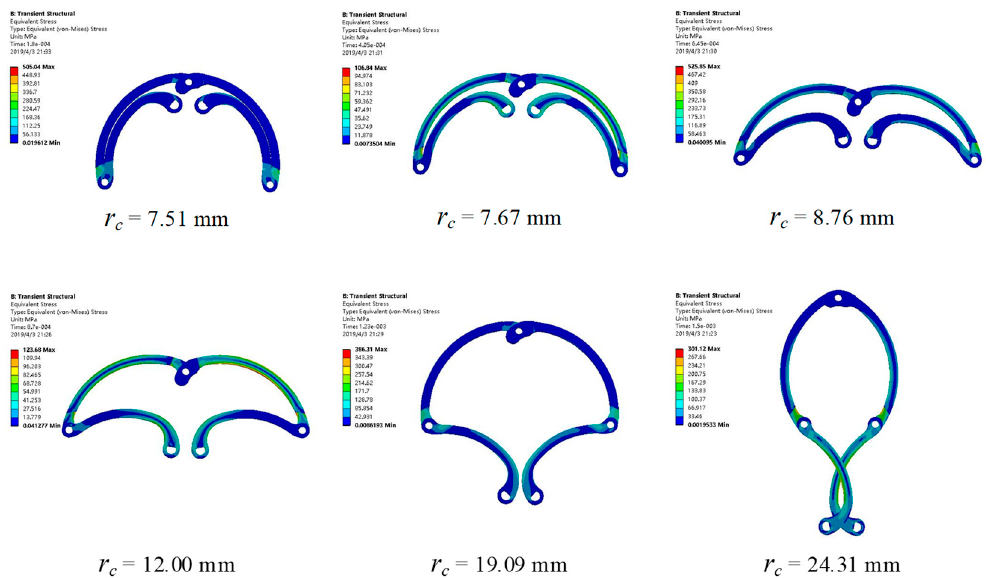
Figure 11. The equivalent stress of expanding arm.